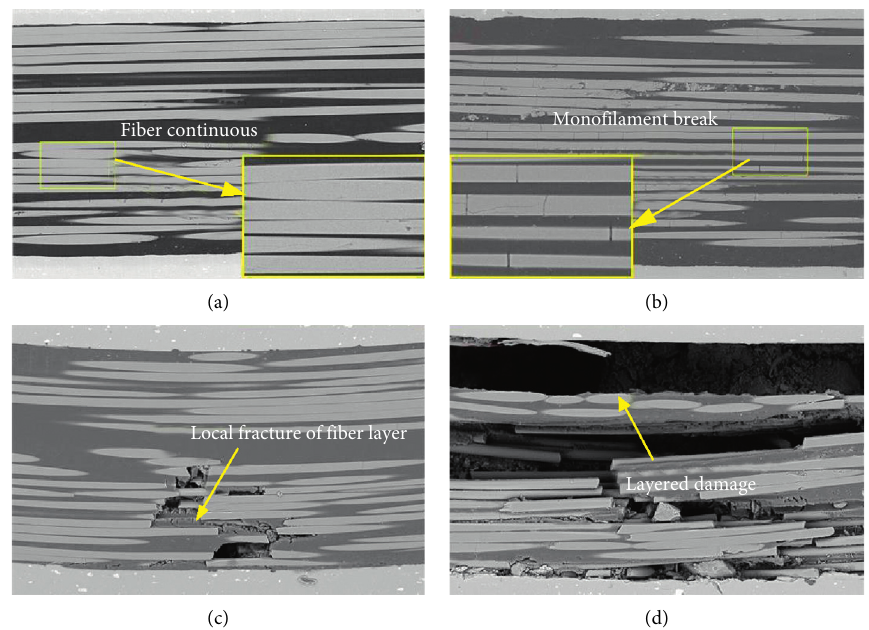
Figure 13: Microstructure of laminates in each stage of unidirectional laminate bending test observed by SEM (FEI Quanta 200) [51]. (a) Elastic phase. (b) Plastic phase. (c) Fiber failure segment. (d) Layer failure